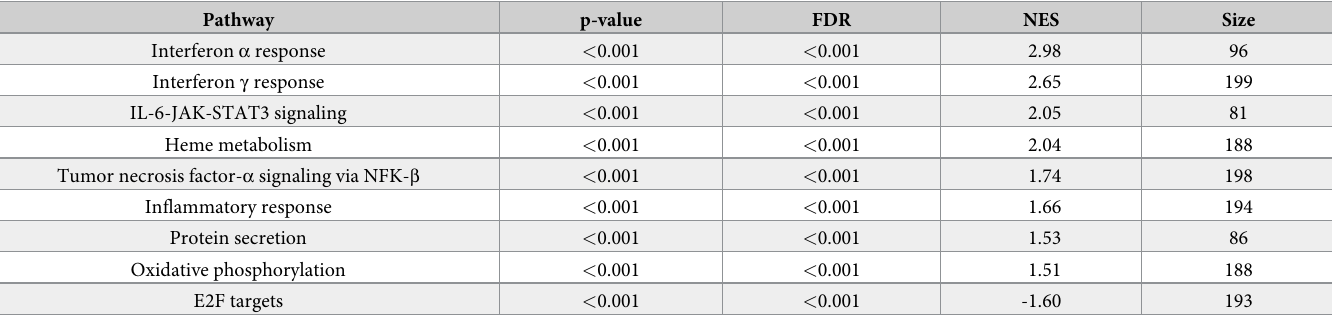
Table 3. Gene set enrichment analysis of whole blood gene expression in those who did vs. did not develop NTM-PD. Pathway p-value FDR NES Size Interferon α response <